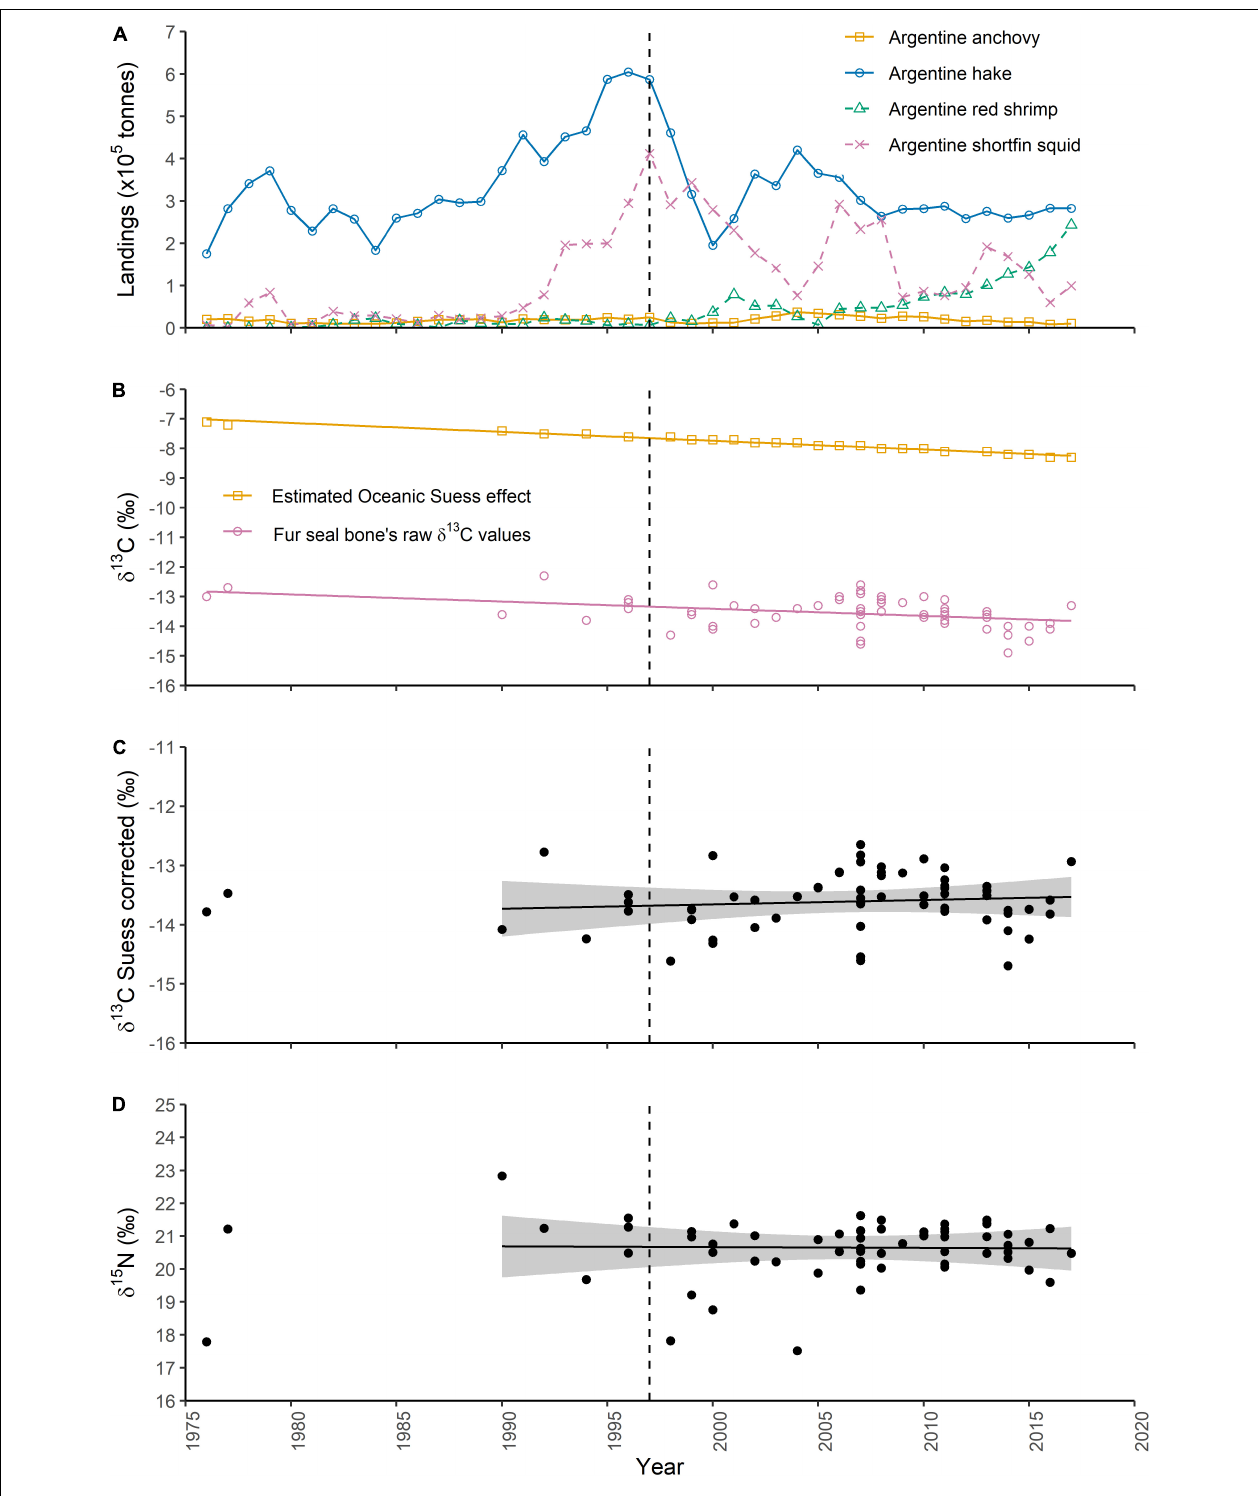
FIGURE 1 | (A) Fishery landings of short-fin squid, hake, anchovy and red shrimp off Argentine coast (Sánchez et al., 2012; Navarro et al., 2014, 2019; MPyT-SA, 2020). The dashed vertical line in 1997 indicates when the hake fishery collapsed. Temporal trend in the stable isotope ratios in bone collagen of subadult and adult male South American fur seals from northern and central Patagonia: (B) raw δ 13 C values (empty pink circles) and the expected change in δ 13 C in the ocean caused by anthropogenic activity, namely the Oceanic Suess effect (empty orange squares); (C) Suess corrected δ 13 C values; and (D) δ 15 N values. The shaded gray bands surrounding the estimated trends in (C,D) are approximate 95% across-the-function confidence intervals.